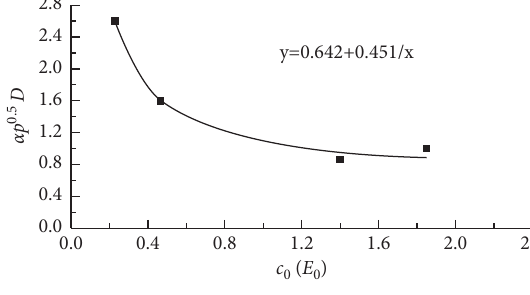
Figure 21: Curve of �� ρ